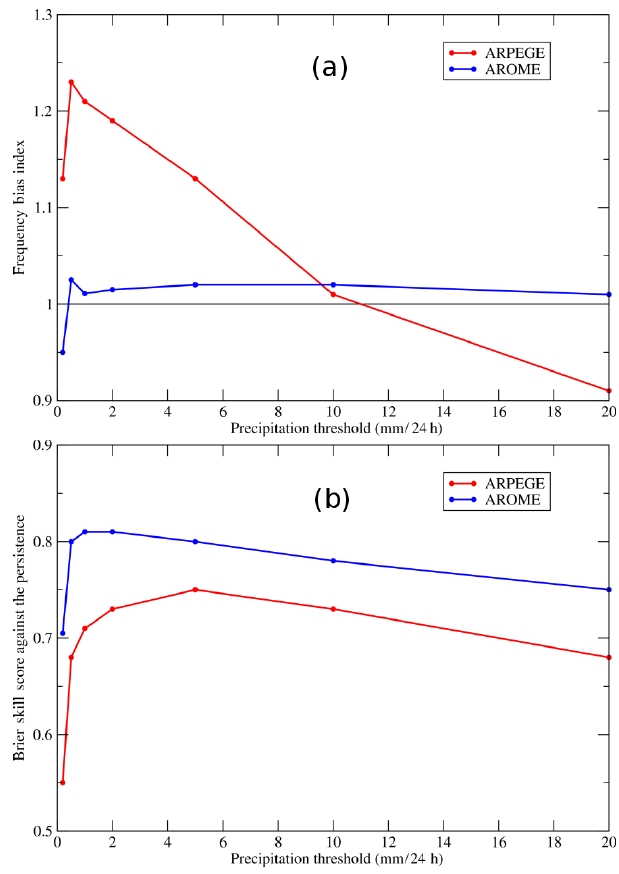
Figure 4. Frequency bias index (a) and Brier skill score (b) against the persistence for a fixed neighborhood of about 50km (Amodei et al., 2015) computed for 24h accumulated precipitation over France as a function of classes of precipitation (0.2, 0.5, 1, 2, 5, 10, 20mm per 24h). Forecasts are provided by the AROME-France and ARPEGE operational NWP systems at Météo-France, the start time is 00:00UTC, the forecast lead time is 30h, and the scores are computed for the year 2016. The ANTILOPE precipitation analy- sis (Laurantin, 2008), combining radar and gauge data, is taken as reference. All data were interpolated on a regular grid of